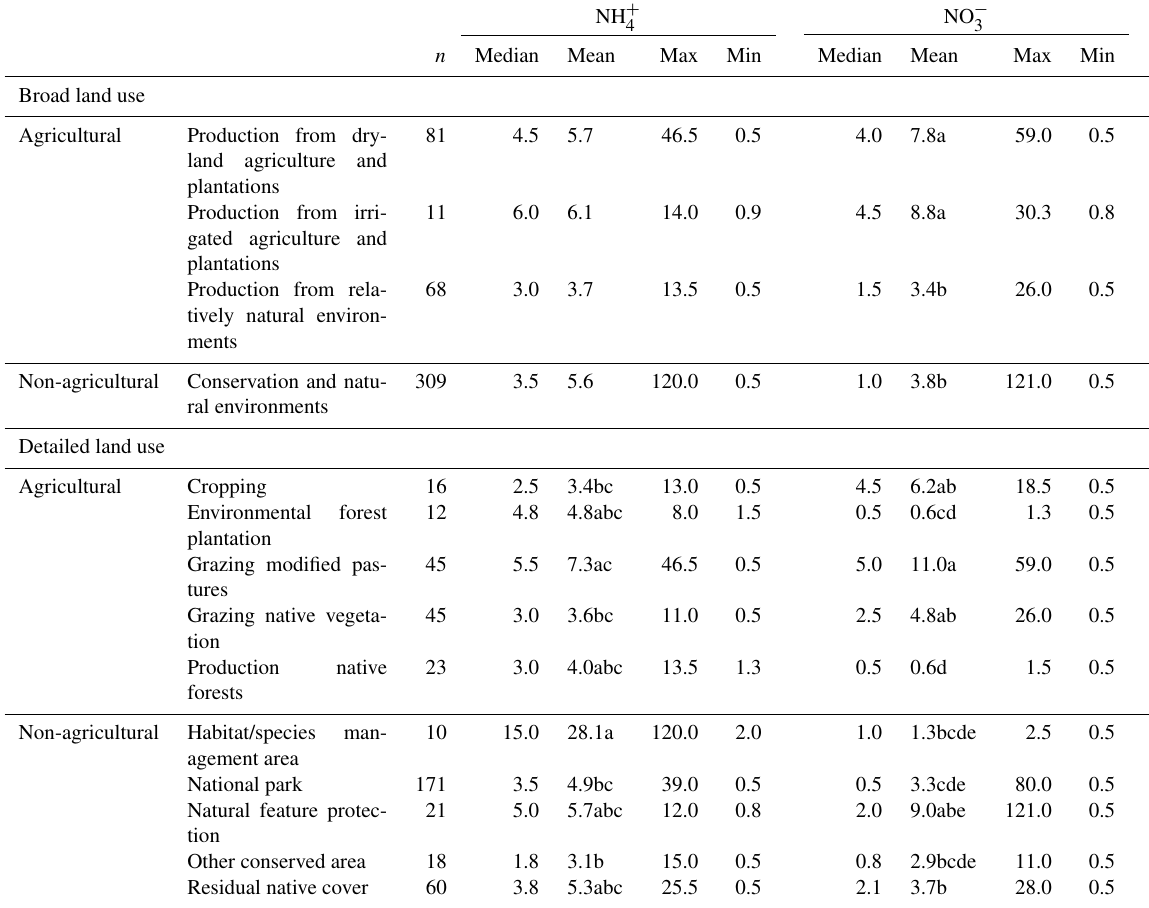
+ and NO − contents (mgNkg − 1 ) in Australian soil by land use across 469 sites. Means with different letters are Table 1. Summary of NH 4 3 significantly different at p < 0 . 05, based on Tukey’s HSD on the log of the values. Any categorical variables with a sample size of < 10 are considered in the multiple mean comparisons but not presented in the table. See Table S1 for the definition of land